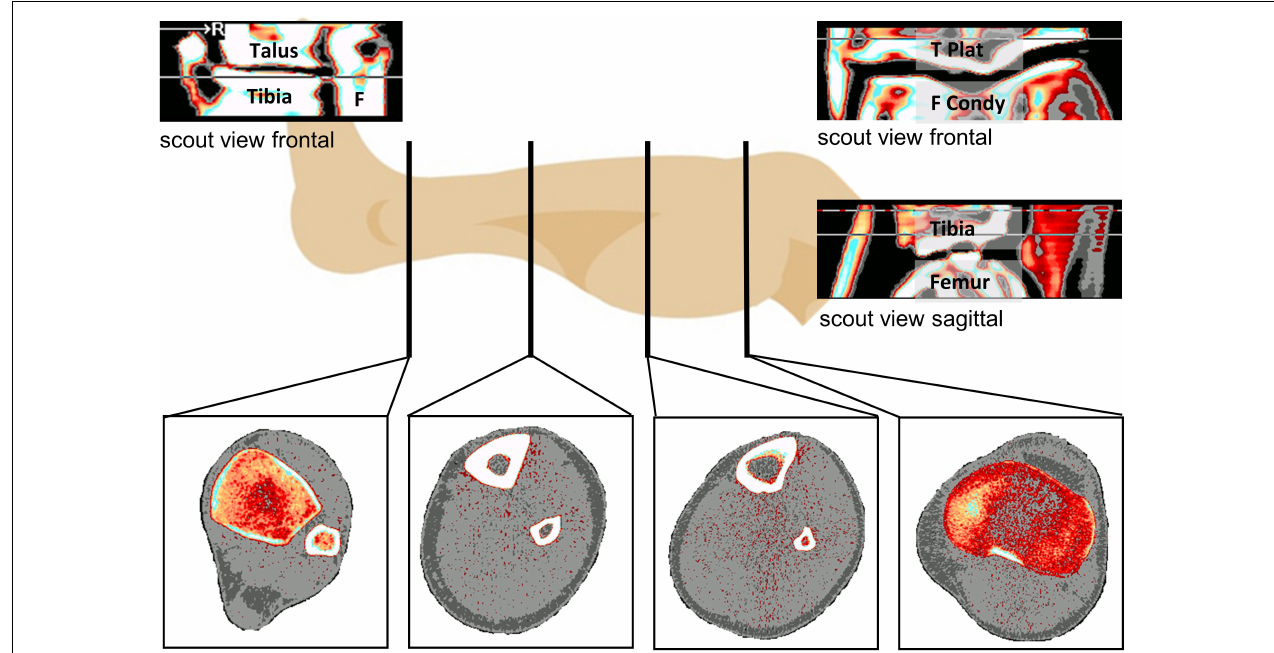
FIGURE 1 | Overview about the analyzed measurement sites (at the bottom) from left to right with TIBIA_04 (Epiphysis at the ankle), TIBIA_38 and TIBIA_66 at the diaphysis and TIBIA_98 (Epiphysis at the knee joint). 04, 38, 66, and 98 represent the relative position regarding the tibia length from ankle joint to knee joint. Top left is the distal frontal scout view (Tibia, Talus, F: Fibula), top right the frontal proximal scout view (F Condy: Femur Condyles, T Plat: Tibia Plateau), below that the sagittal proximal scout